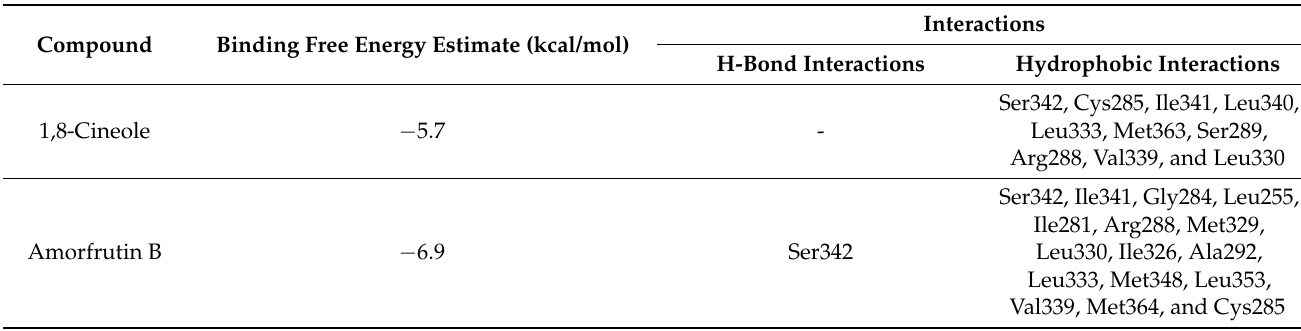
Figure 1. Molecular docking and dynamics of 1,8-cineole with PPARγ. The docked pose and the interactions at the binding site of PPARγ. ( a ) Interactions of amorfrutin B and ( b ) interactions of 1,8-cineole. The analysis of the MD simulation ( c ) RMSD in PPARγ backbone atoms, ( d ) RMSD in 1,8-cineole atoms and amorfrutin B atoms, ( e ) RMSF in PPARγ residues, ( f ) hydrogen bond analysis for 1,8-cineole and amorfrutin B, ( g ) The analysis of trajectories extracted at different time intervals (50–150 ns) of the MD simulations. Table 1. Molecular docking results.